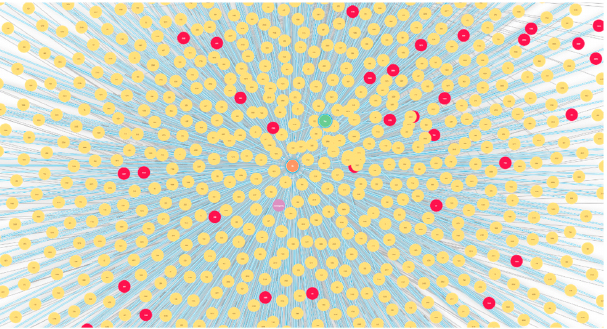
Figure 3. An example of the knowledge graph constructed from the tabular data. Red nodes represent relatively older patients whose age is higher than 45 years.